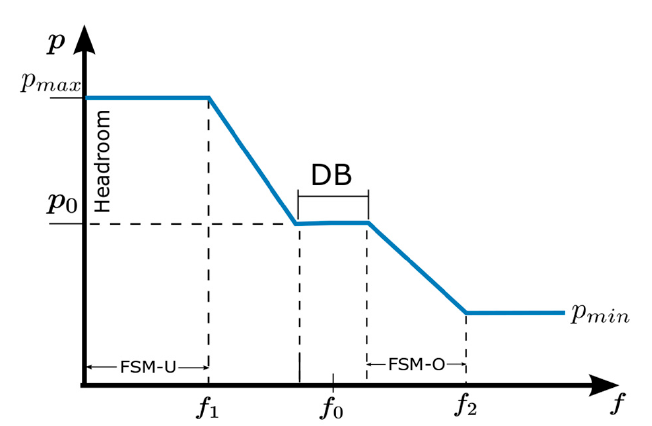
Figure 4. Illustrative example of a DRES operating as a frequency containment reserve (FCR).